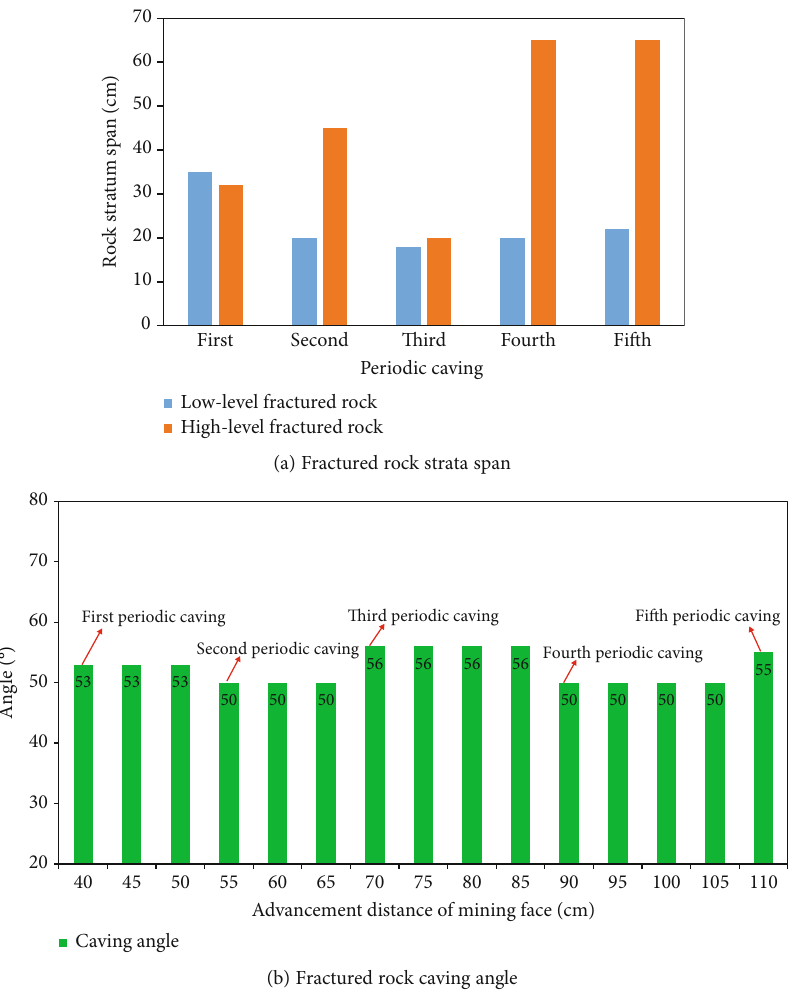
Figure 5: Fractured rock parameters of fi ve periodic caving of extra-thick